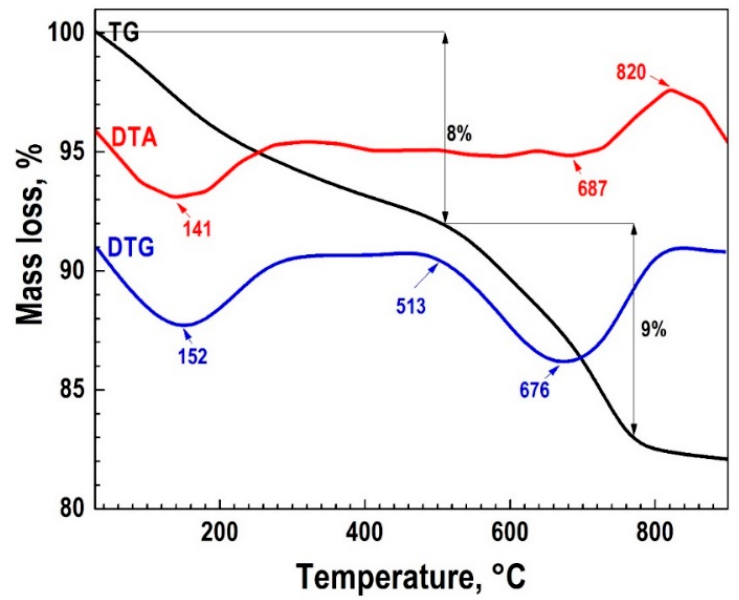
Figure 2. Thermogravimetric analysis (TG) of the autoclave synthesis reaction product at 220 °C in the CaSO 4 ·2H 2 O–SiO 2 · n H 2 O–KOH–H 2 O system.